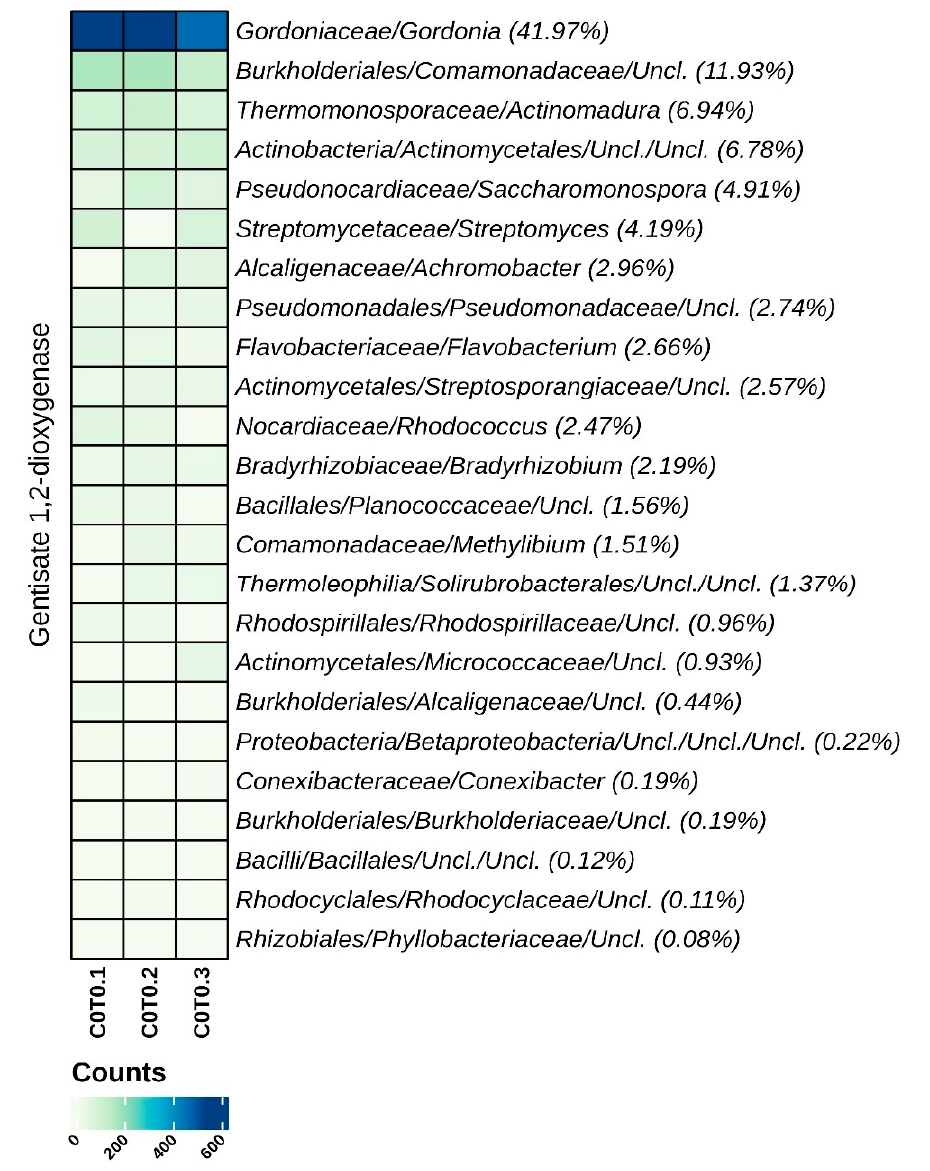
Figure 7. Functional Heatmaps of the Gentisate 1,2-dioxygenase contribution by identified ASVs aggregated at the Genus level, as inferred by PICRUSt2 in the three biological replicates. On rows, the nearest identified taxonomic level for each contributing ASV is reported, followed by its relative percentage contribution to the functional feature. Hierarchical clustering of columns was performed by Pearson correlation, based on Euclidean distance.